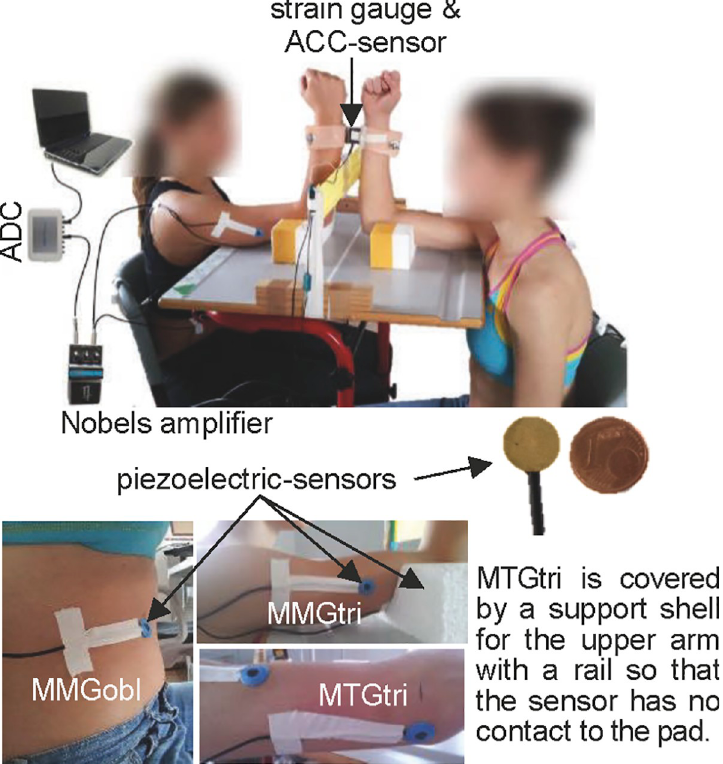
Fig 1. Setting. The partners are interacting with their distal forearms, which are coupled by two shells incl. the strain gauge and accelerometer. The piezoelectric sensors for MMG are fixed on the abdominal external oblique muscle (MMGobl), on the lateral head of the triceps brachii muscle (MMGtri) and–to capture the MTG of the triceps tendon (MTGtri)–on the olecranon fossa. The MMG/MTG-signals are amplified with the Nobels pre-amp booster pre-1. (Fig 1 of [9]; modified with